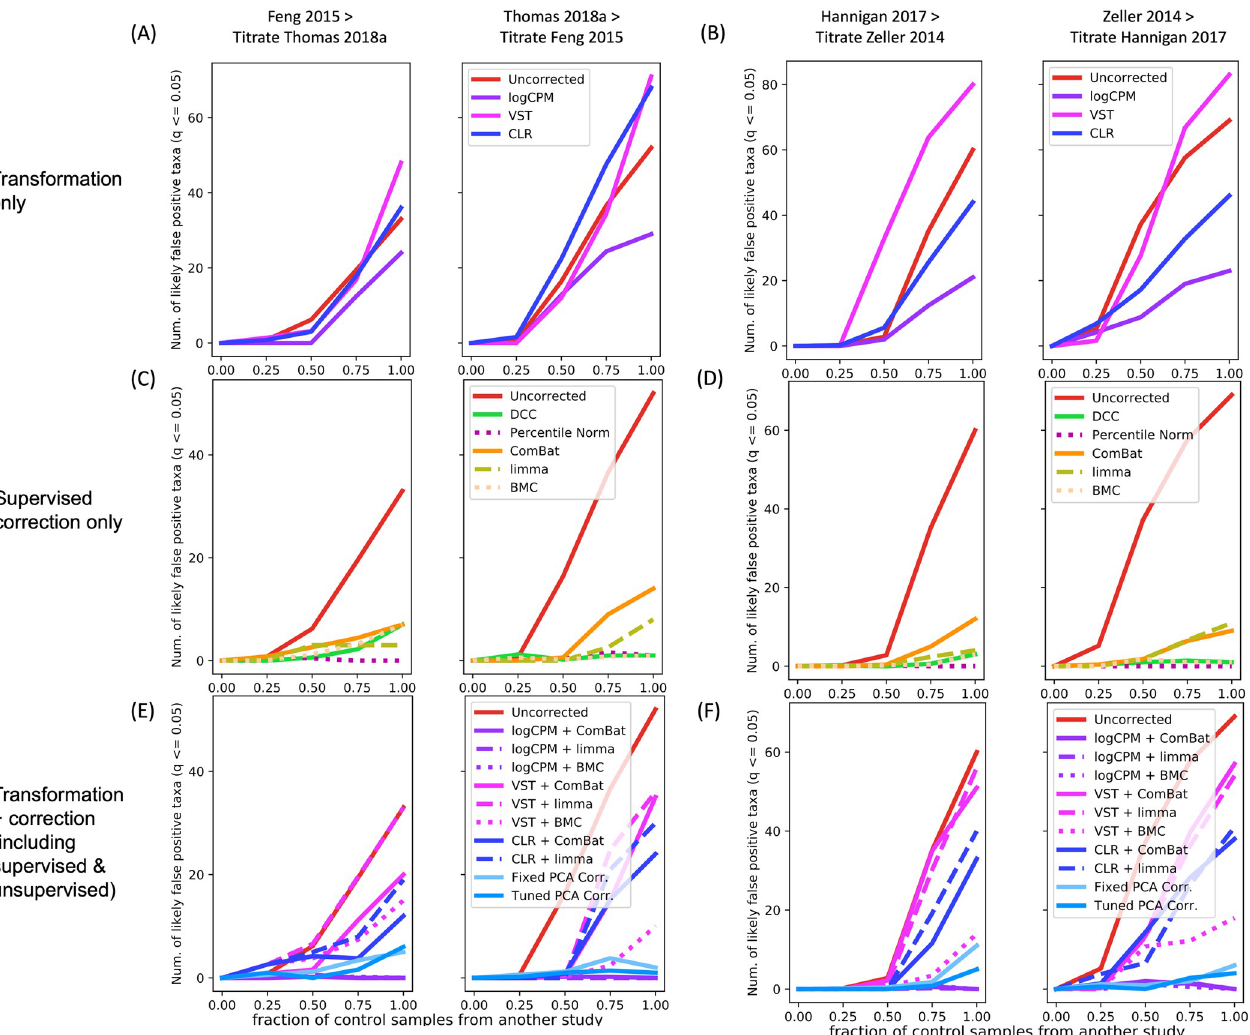
Fig 3. Spurious association of taxa with case-control status without appropriate correction. (A) We tested the number of associations identified after replacing the controls from the CRC-WGS study sequenced by [1] referred to as Thomas et al. 2018a with controls from Feng et al. at increasing proportions and vice versa. (B) Similarly, controls in the CRC-WGS study Hannigan et al. [79] were replaced with controls from Zeller et al.[74] and vice versa (S7 Fig). BMC + CLR was an outlier and excluded for clarity of visualization, but the summary of mean associations of BMC + CLR is in S1